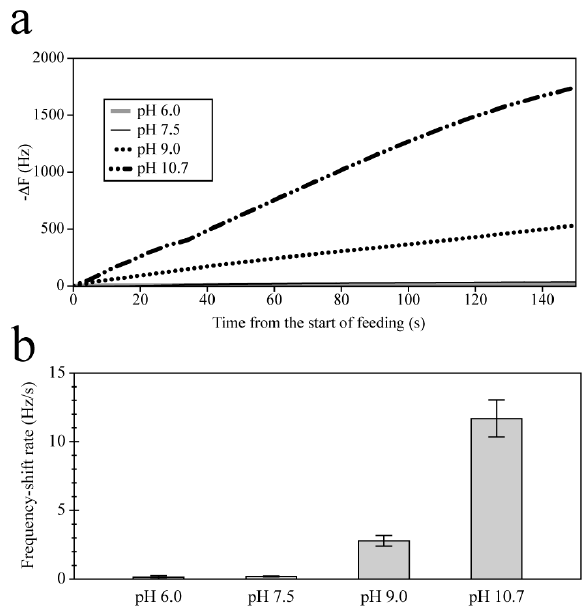
Figure 2. ( a ) Typical frequency change patterns during quartz crystal microbalance (QCM) measurements of 100 mg/L palmitic acid at different pH levels, the horizontal axis represents the time from the start of feeding into the flow cell; and ( b ) absolute values of average frequency-shift rates ( n = 3) within the linear ranges (50–150 s).